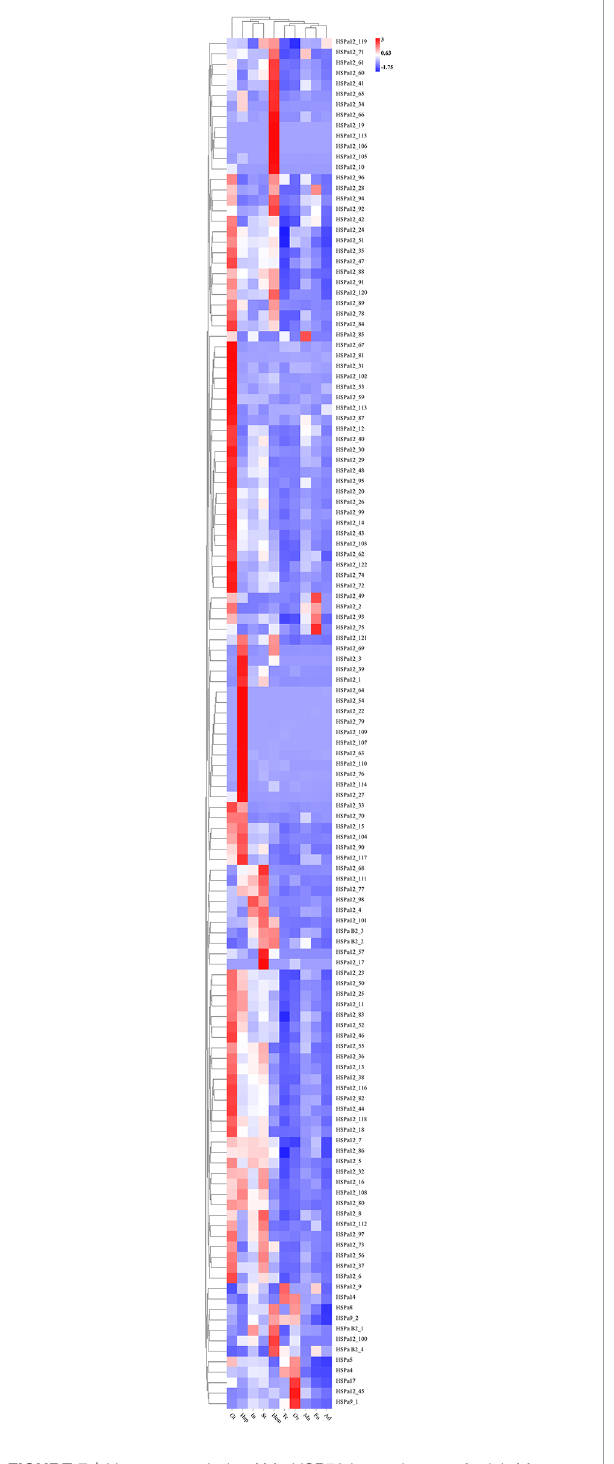
FIGURE 7 | Heatmap analysis of MmHSP70 in ten tissues of adult M. mercenaria based on the FPKM. The name of tissues was abbreviated as Te, testis; Ov, ovary; Ma, mantle; Gi, gill; Fo, foot; In, intestine; Hep, hepatopancreas; St, stomach; Ad, adductor muscle; and Hem, hemolymph. The colour scale represented Z-score.